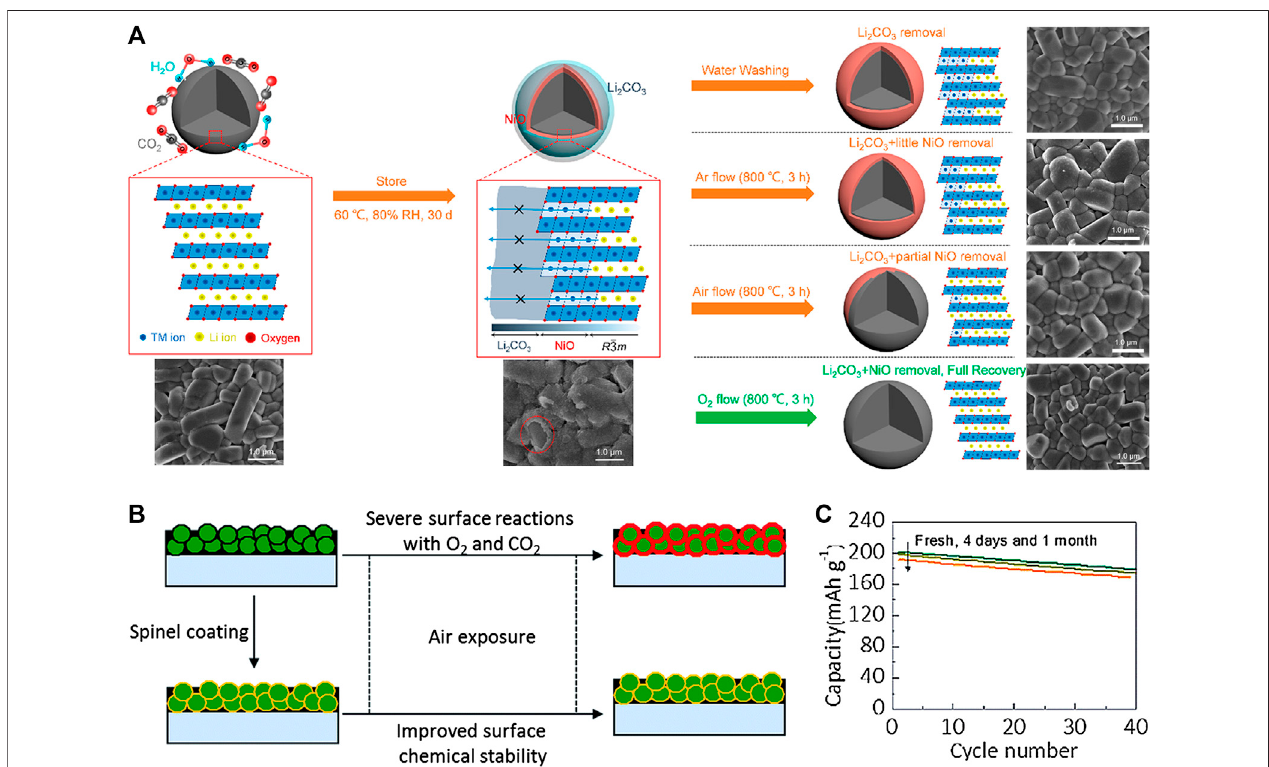
FIGURE 3 | (A) Scheme illustration of the failure and recovery behaviors of the stored NCM701515 with the structure and surface morphology evolution. Adapted from [Huang et al., 2019a] with permission from American Chemical Society. (B) Schematic view of the effect of spinel LiMn1.9Al0.1O4 coating on the Ni-rich layered oxide surface and (C) The cycling performanceof spinel LiMn1.9Al0.1O4 modi fi ed sample after air exposure. Adapted from [Oh et al., 2016] with permission from Royal Society of